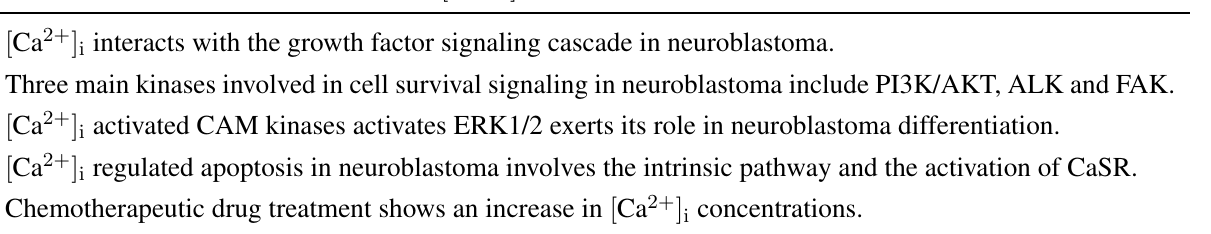
Table 2. An overview on the role of [Ca 2+ ] i in neuroblastoma.